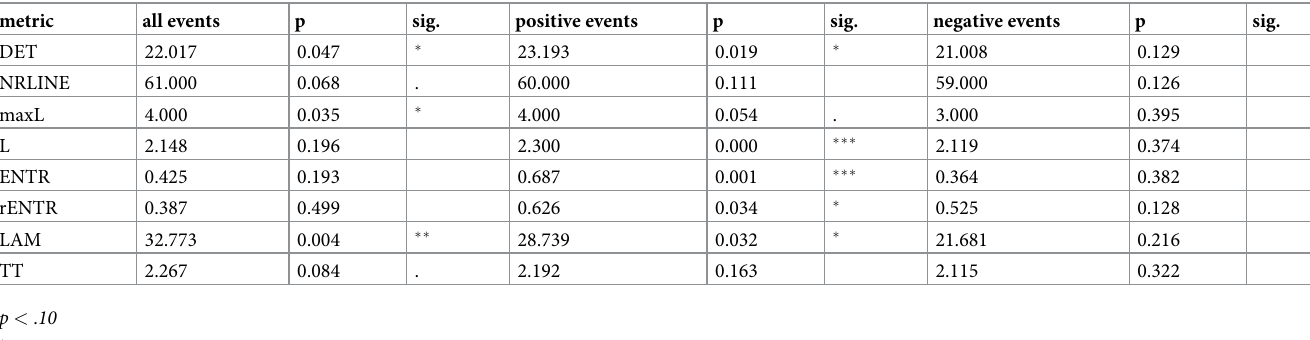
Table 2. CRQA results for source and target